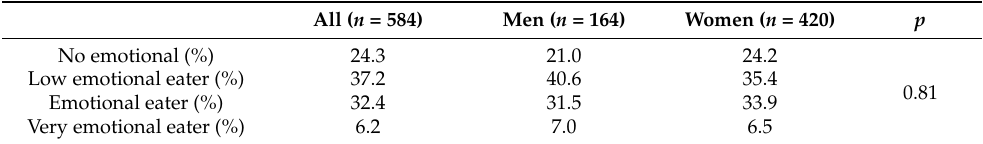
Table 4. Emotional eating by sex according to